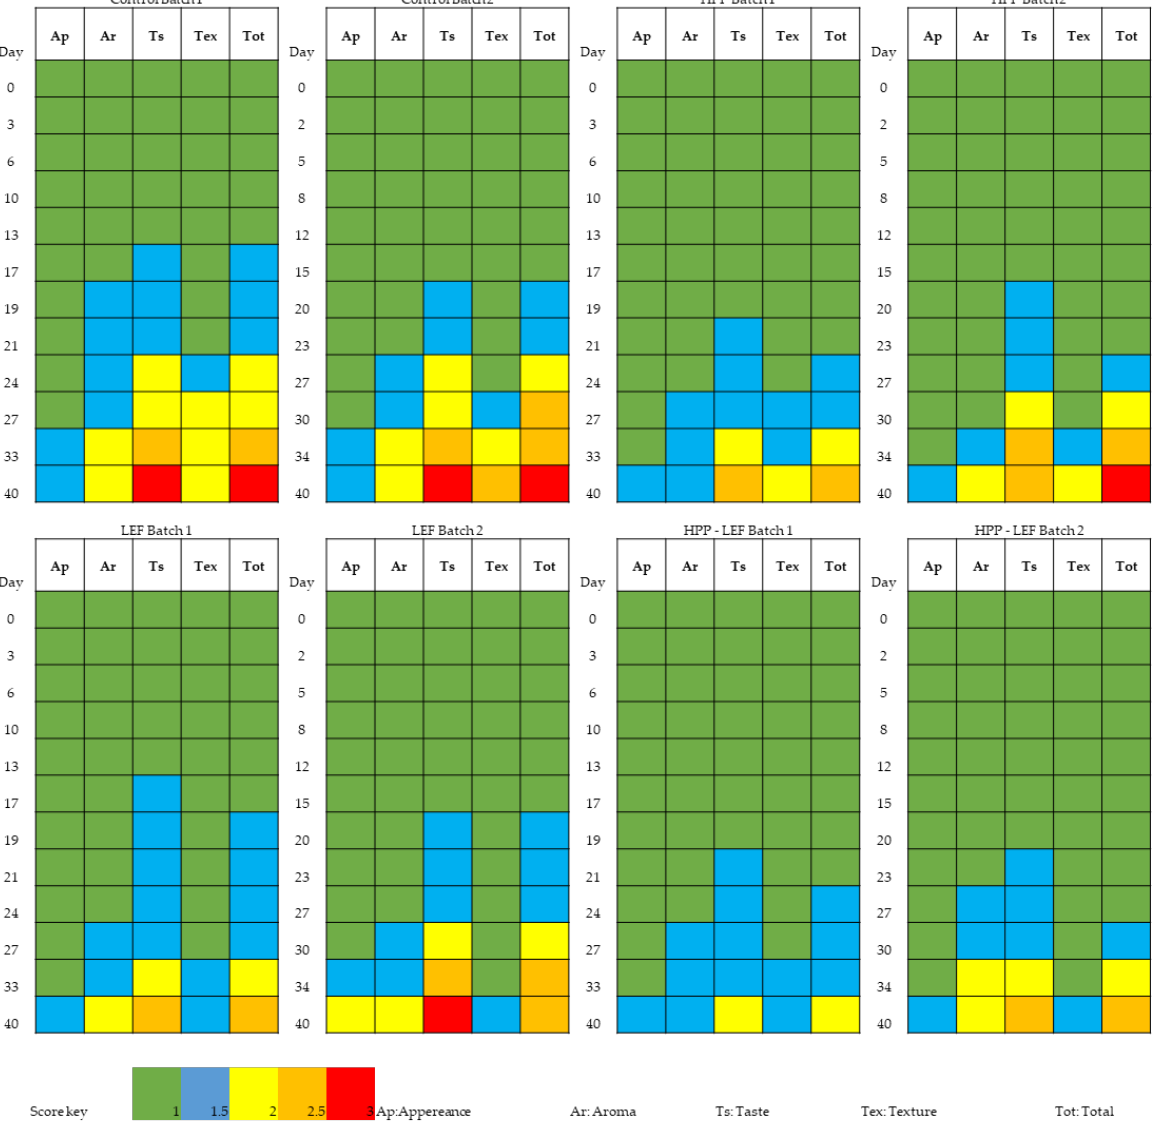
Figure 3. Sensory scores of cheese slices treated or not with HPP, with or without LEF during storage at 4 °C.